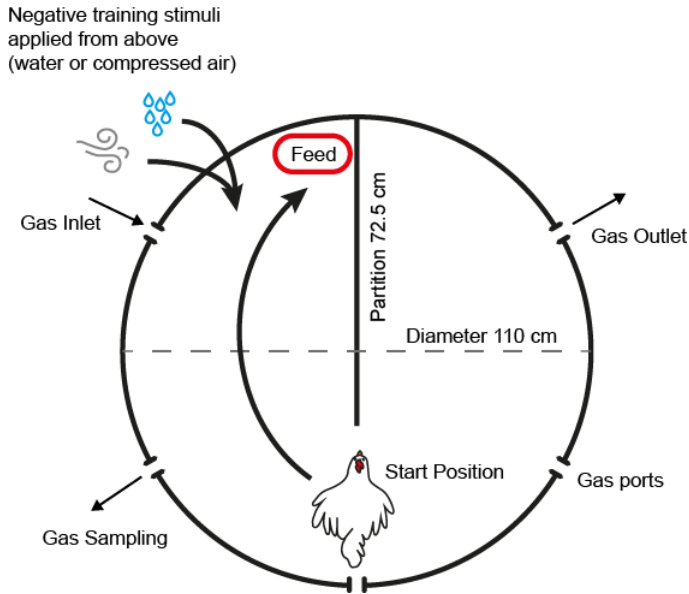
Figure 1. Schematic of the test arena. The start position refers to the location and orientation of the animal at the start of the training and test session. Negative stimuli for training were applied from above the animals’ heads with the chamber lid open and in the direction indicated by the arrows. Except for the hole for gas inlet, the holes for hose connection located on the sides of the arena were closed.